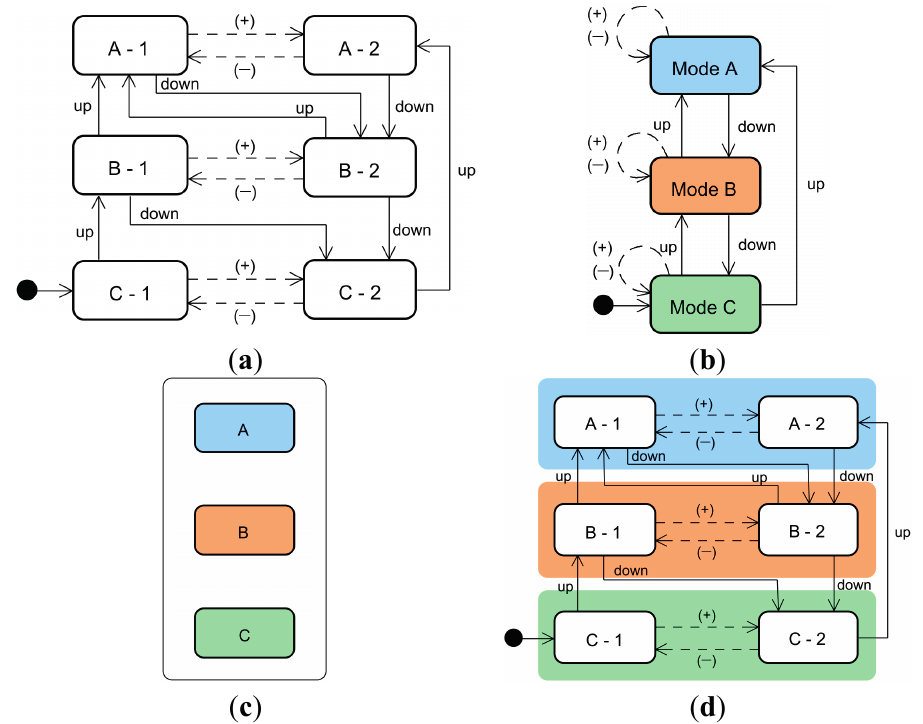
Figure 1. Machine and interface models and a user interface for an example machine: ( a ) machine model; ( b ) initial interface model; ( c ) initial user interface; and ( d ) combined machine and interface